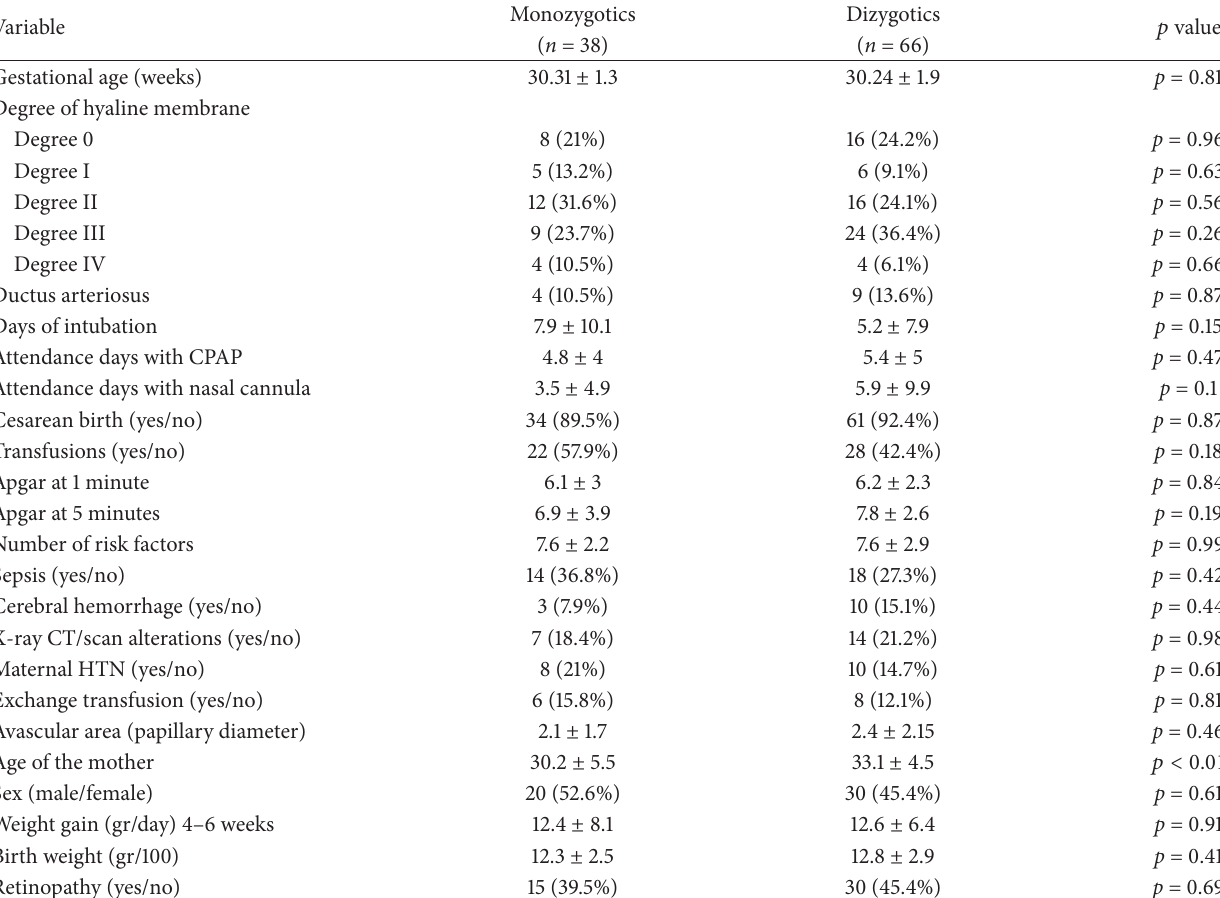
Table 1: Risk factors for the development of ROP were comparable between monozygotic and dizygotic twins.